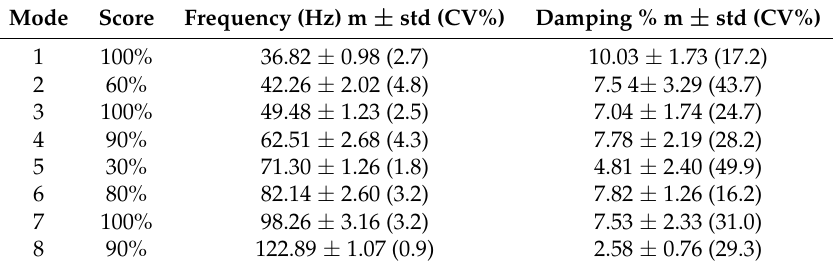
Table 4. Identification results: repeatability (Protocol 1). m: mean, std: standart deviation, CV: coefficient of variation.